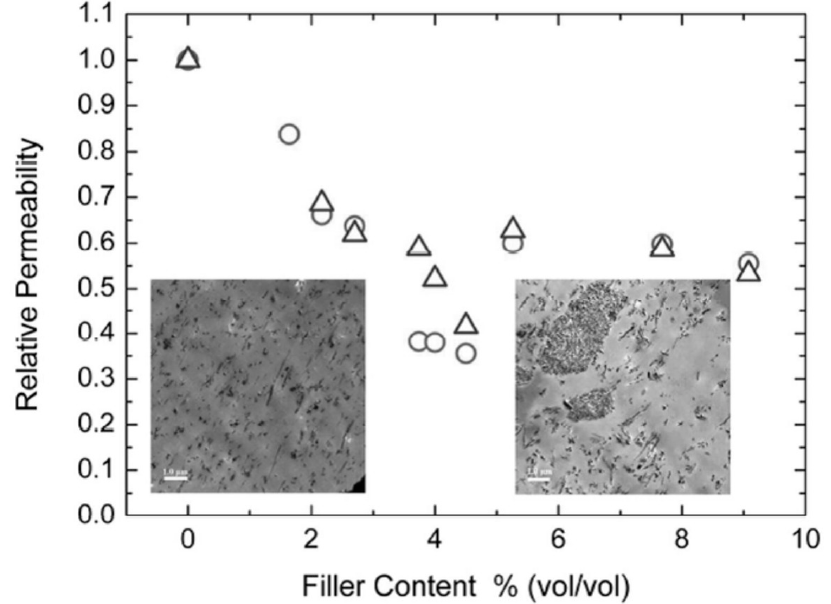
Figure 21. Chrysotile nanotubes (ChNTS = SNT) containing polyimide nanocomposites were prepared by solution mixing-casting method [130].